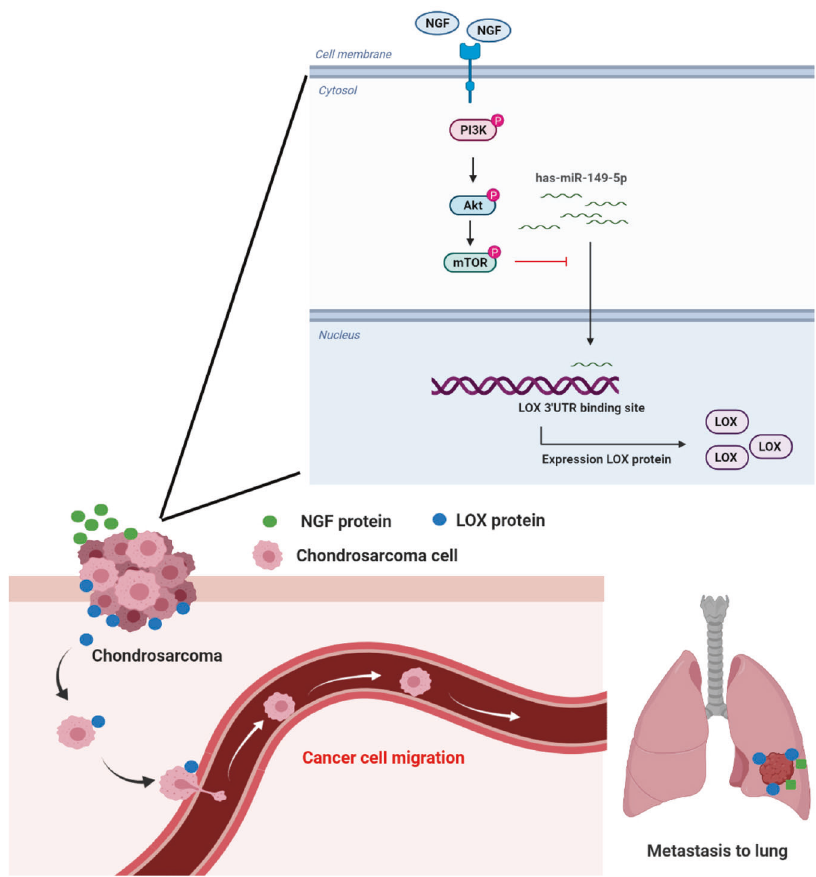
Fig. 8 Schema illustrating the effects of NGF in chondrosarcoma metastasis. NGF promotes LOX-dependent metastasis of chondrosarcoma by suppressing miR-149-5p synthesis via the PI3K, Akt, and mTOR signaling